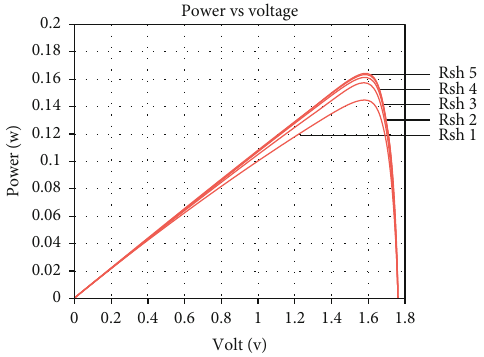
Figure 18: Power vs. voltage characteristic curve [91].